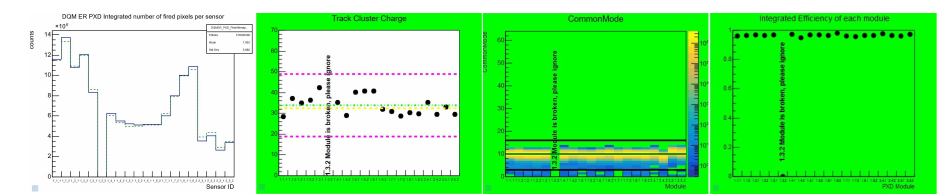
Figure 6. Basic PXD diagnostic plots available for Control Room shifters, left to right: Fired pixels per sensor for each sensor; Cluster charge MPV; Common mode correction in U direction (in rows); Sensor e ffi ciency.